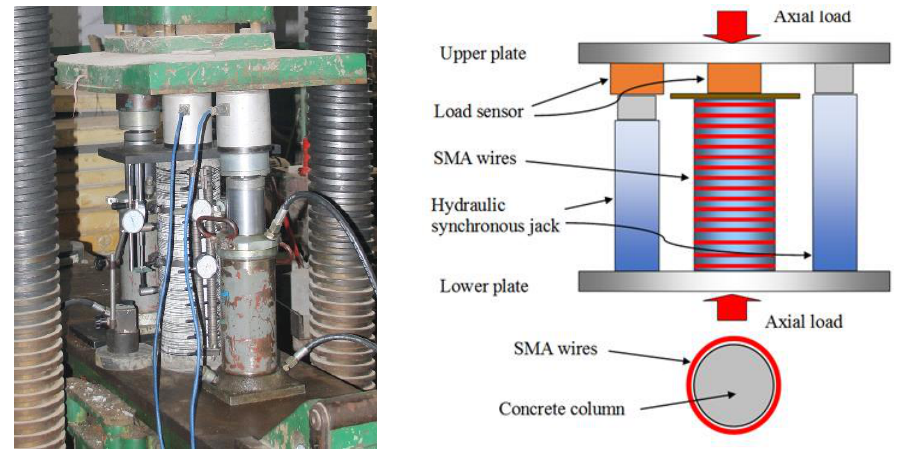
Figure 4. Axial compression test device and structure diagram.